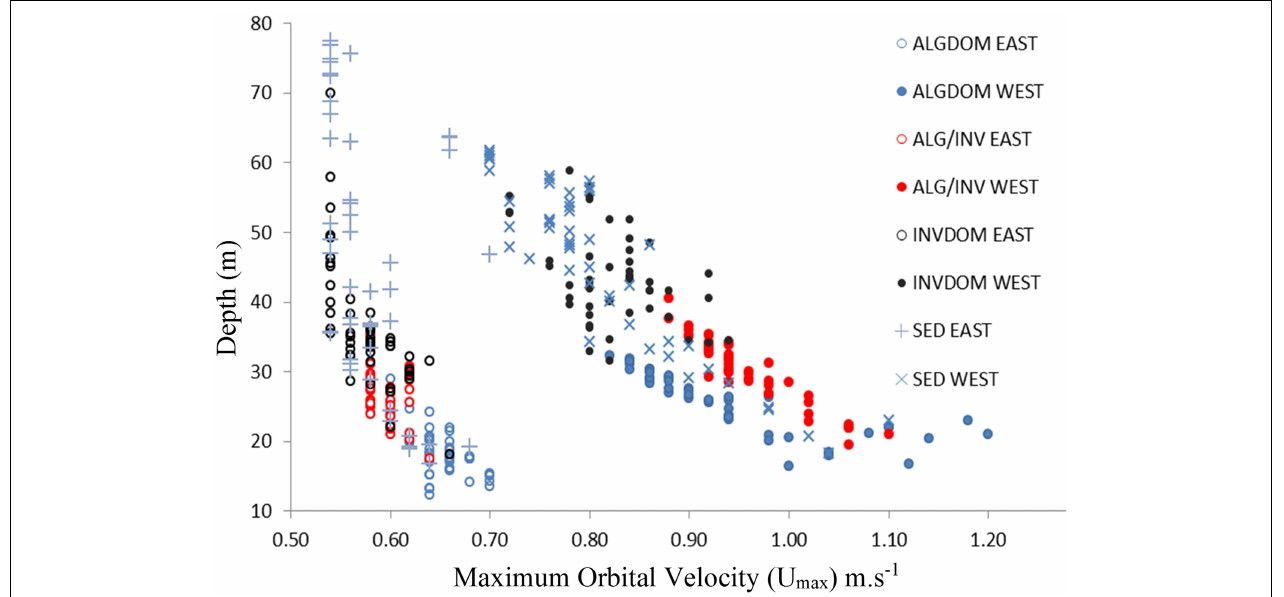
west. Habitat classes are described in Table 2 . ALGDOM, Algal dominated reef; ALG/INV, mixed algae and sessile invertebrates; INVDOM, reef with sessile invertebrates; SED, unconsolidated sandy sediments.